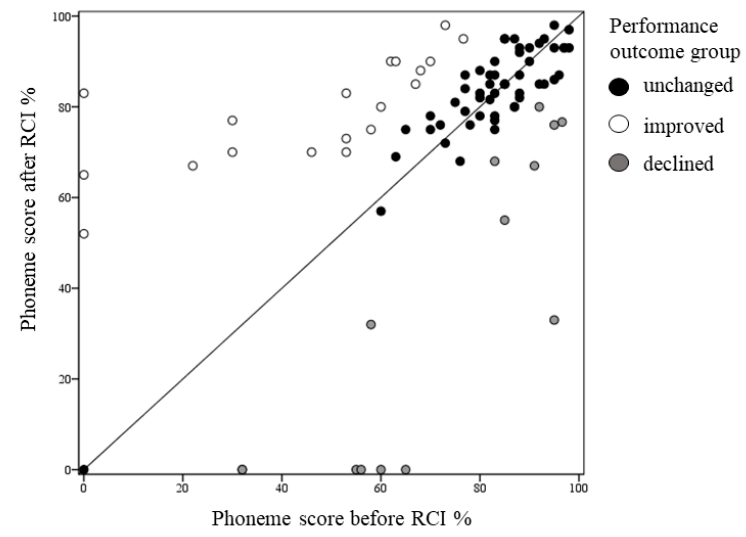
Figure 4. Individual phoneme scores before and after revision cochlear implantation (RCI), presented for each case ( n = 86) according to performance outcome groups (unchanged, improved, declined). The diagonal line represents the same scores before and after RCI.